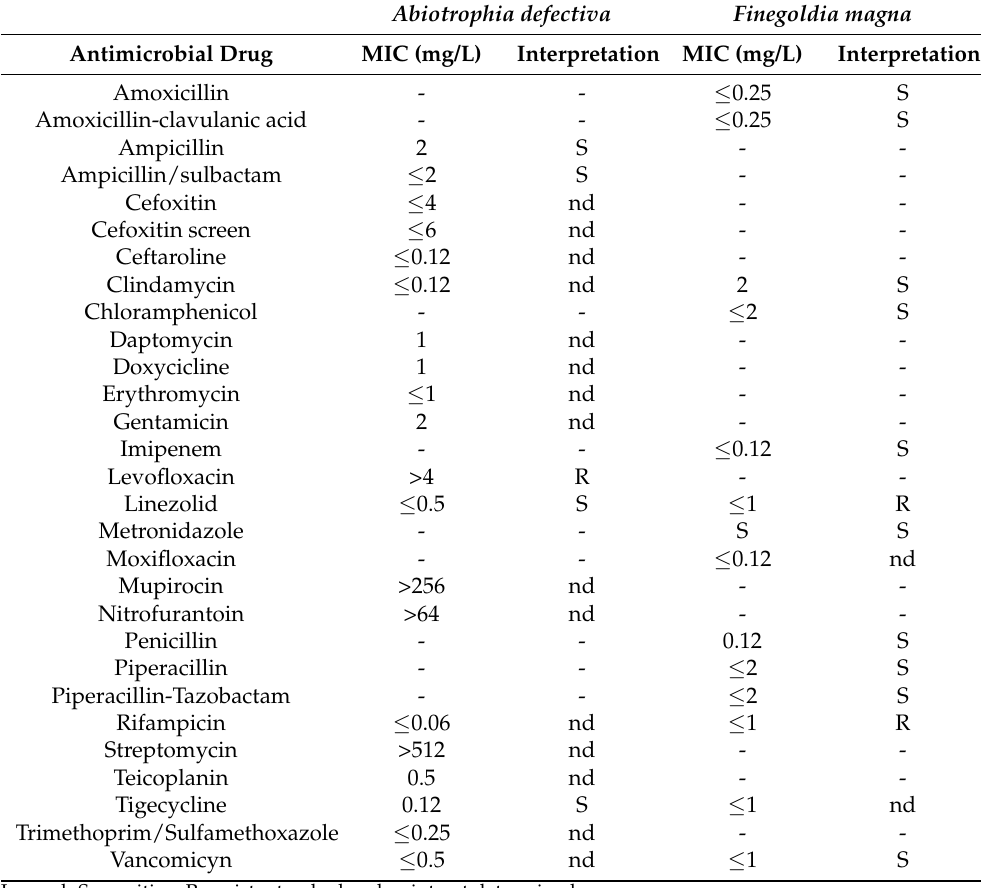
Table 1. Antimicrobial susceptibility test of Abiotrophia defectiva and Finegoldia magna